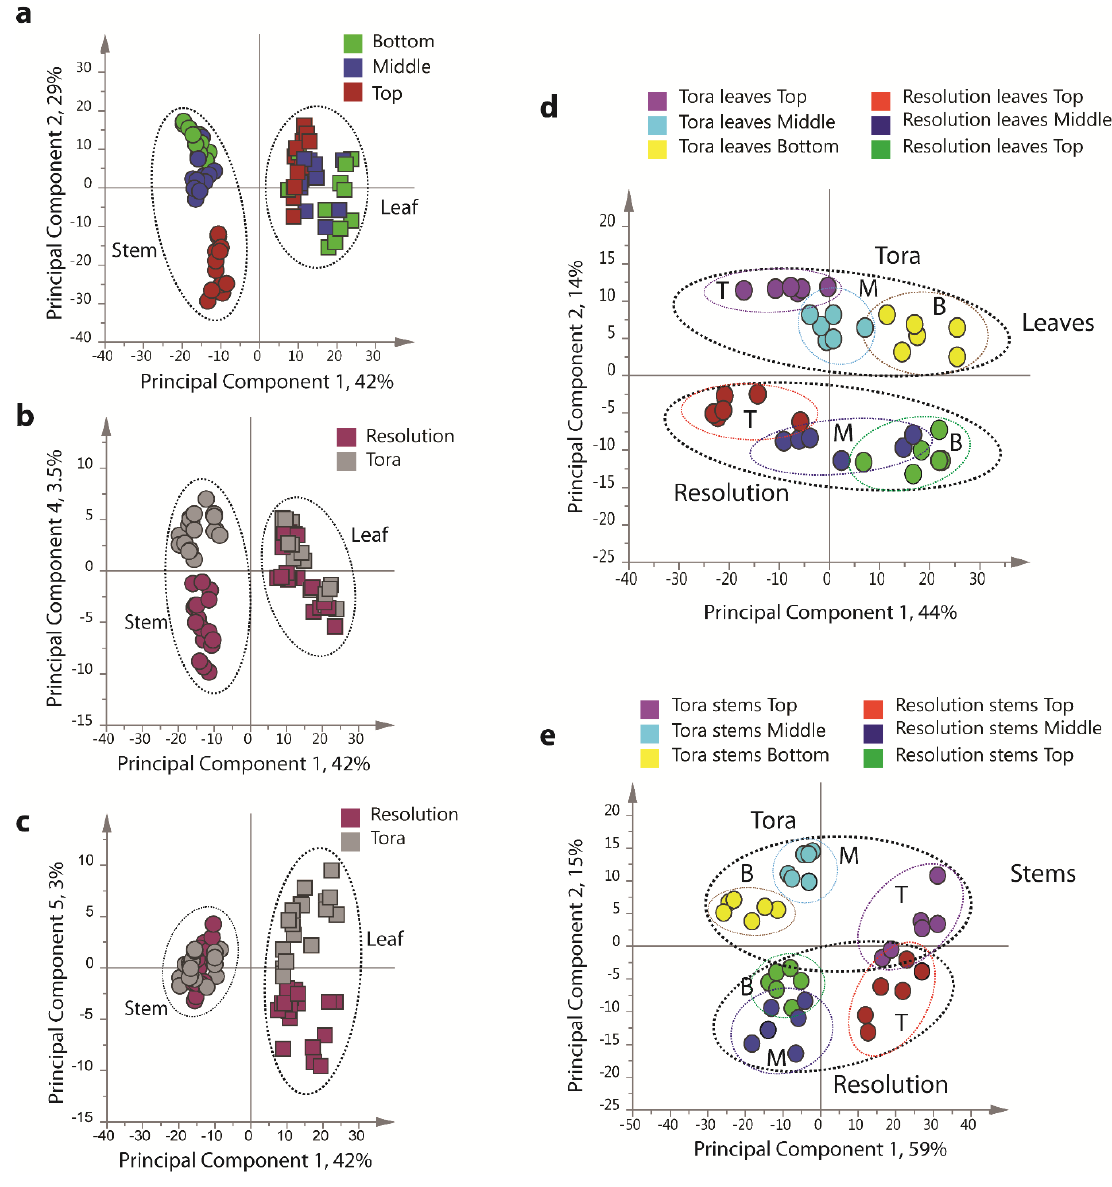
Resolution leaf and stem samples. ( a ) PC1 vs. PC2 of leaf and stem data, coloured by harvest position; ( b ) PC1 vs. PC4 of leaf and stem data, coloured by genotype; ( c ) PC1 vs. PC5 of leaf and stem data, coloured by genotype; ( d ) PC1 vs. PC2 of leaf data only, coloured by genotype and harvest position; ( e ) PC1 vs. PC2 of stem data only, coloured by genotype and harvest position. Harvest position: B: bottom; M: middle; T: